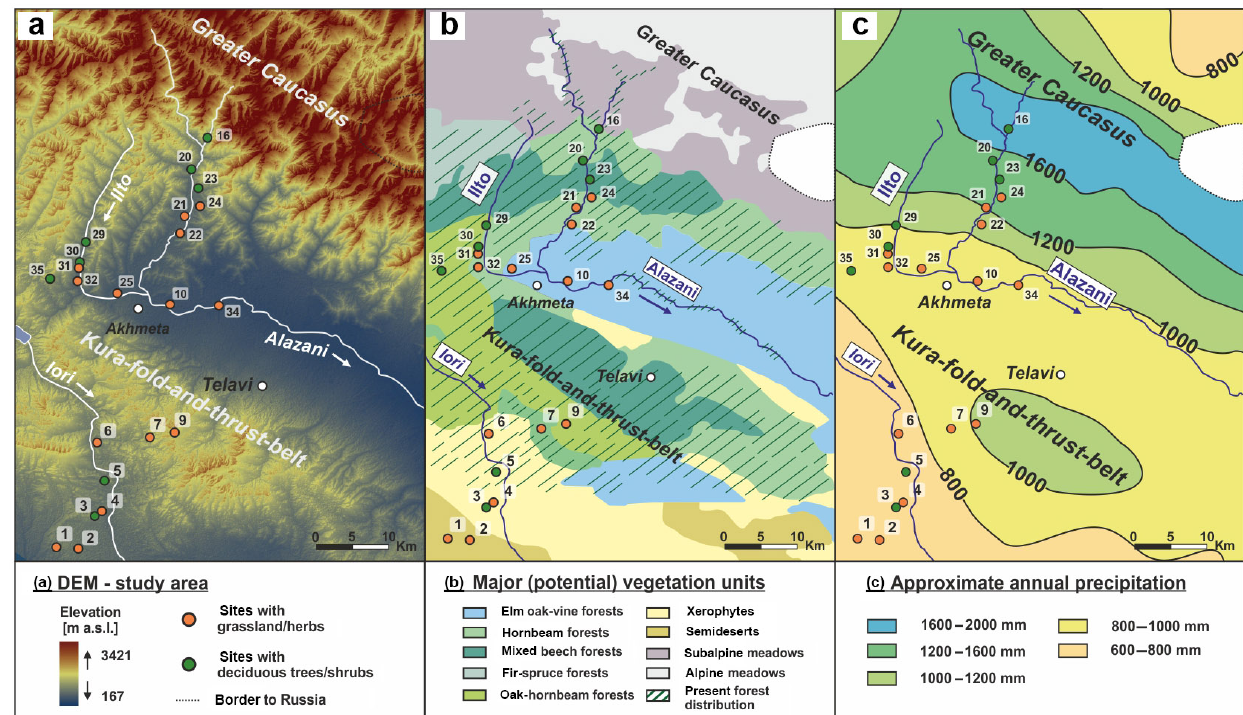
Figure 2. (a) Digital elevation model of the study area (Aster DEM). Locations of plant and topsoil samples are indicated by an orange dot for sites with grassland/herbs, and a green dot for sites with deciduous trees/shrubs. (b) Current natural potential vegetation in the study area (Connor and Kvavadze, 2008). The current distribution of forests in the study area (second half of 20th century) is derived from Soviet military maps 1 : 200000. (c) Approximate annual precipitation in the study area (based on unpublished precipitation map of the V. Bagrationi Geographical Institute Tbilisi that averages precipitation data between 1960 and